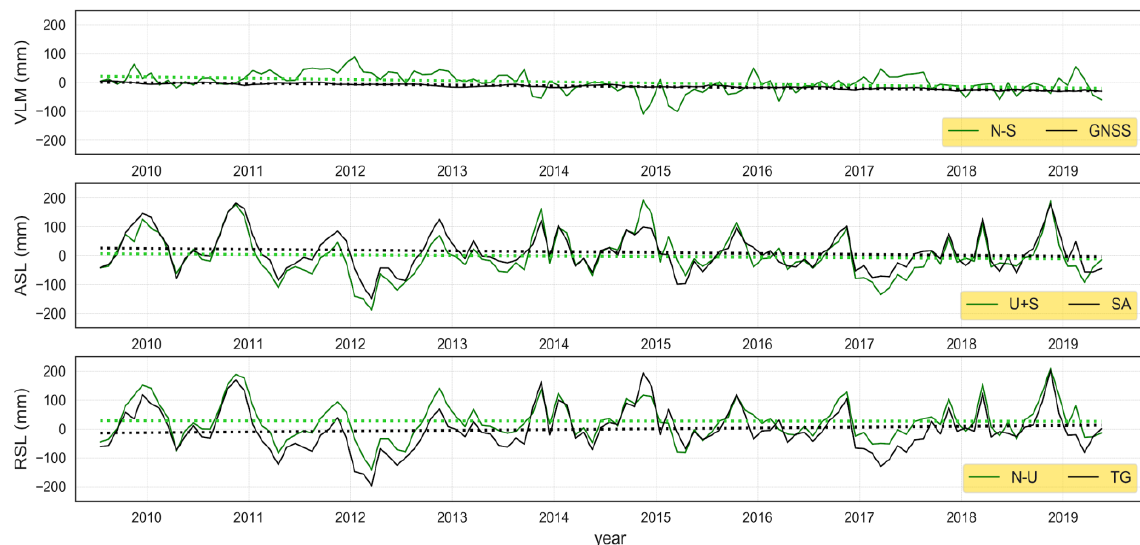
Table 5. U , N and S resulting from the SLE (Equation (1)) where N is the ASL variation, U is verti- cal displacement and S is the RSL variation (values in mm/year). NA = not available. The signifi- cance of the resulting trend varies according to the symbol beside each rate (significance code: *** p < 0.001).